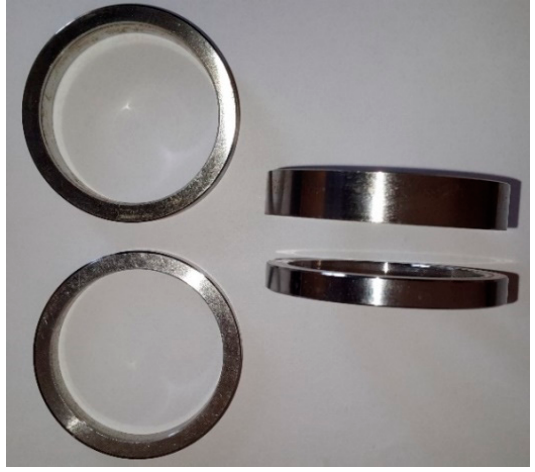
Figure 4. The design of the tribotester: 1—test stand body with a motor; 2—driving shaft; 3—up- per holder of the sample; 4—bottom holder of the sample; 5—fixing components; 6—steel ring samples.